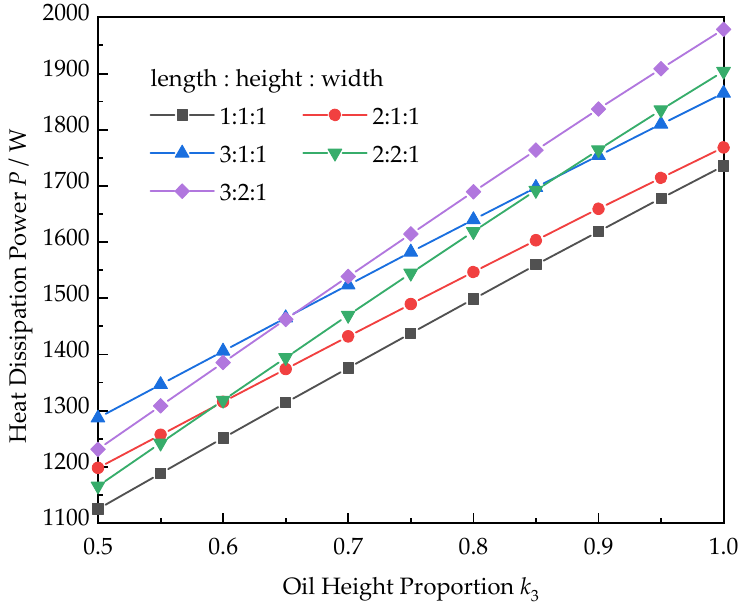
Figure 4. Heat dissipation power with oil height under different length-height-width ratios. It can be seen from Figure 4 that the natural heat dissipation power of the tank is proportional to the liquid level height. That is, the higher the liquid level is, the greater the heat dissipation power is. This also shows that the capacity of the heat conduction of the oil is greater than that of the air. In addition, the value of the natural heat dissipation power is different when the design proportion of the tank is different. Their relationships will be further elucidated in the next section.